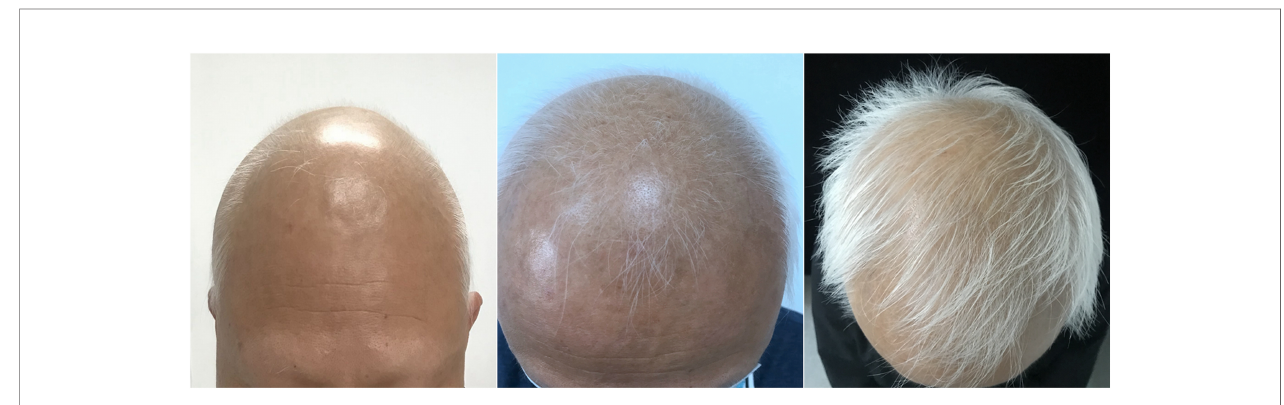
FIGURE 1 | The clinical manifestation of the patient ’ s hair after tofacitinib treatment; at 8, 16, and 24 weeks, the hair has regrown